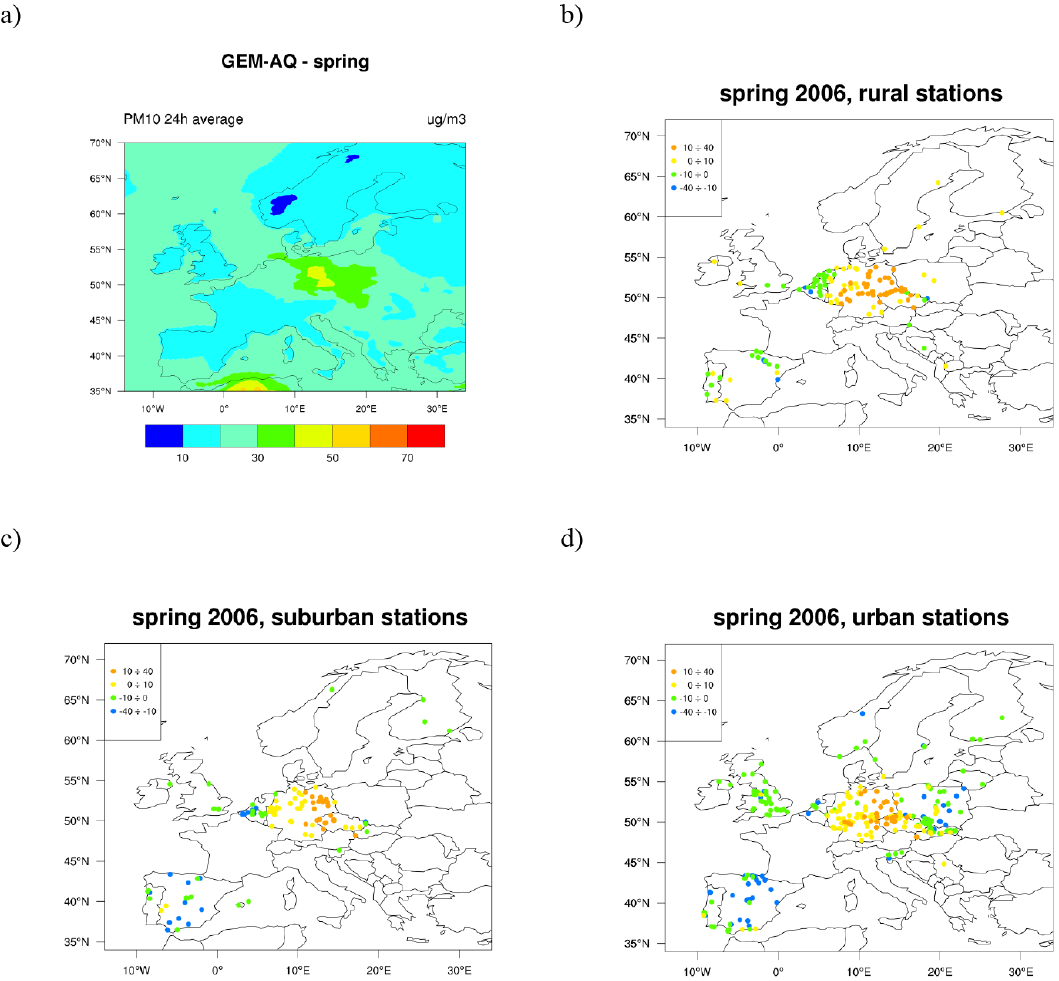
Figure 16. Spring (MAM) 24h average PM 10 concentrations in µgm − 3 (a) , MBE at rural stations (b) , MBE at suburban stations (c) and MBE at urban stations (d)